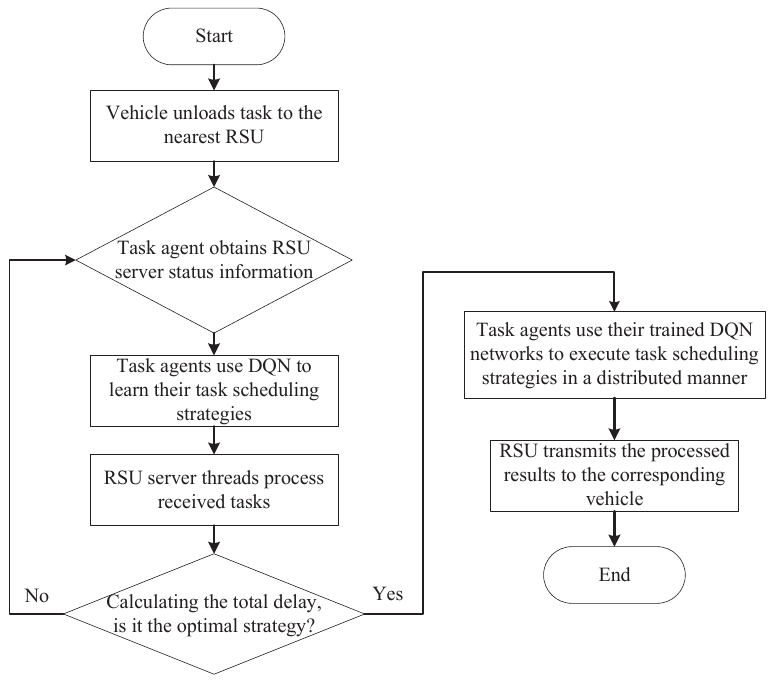
Figure 5. MADQN-based training